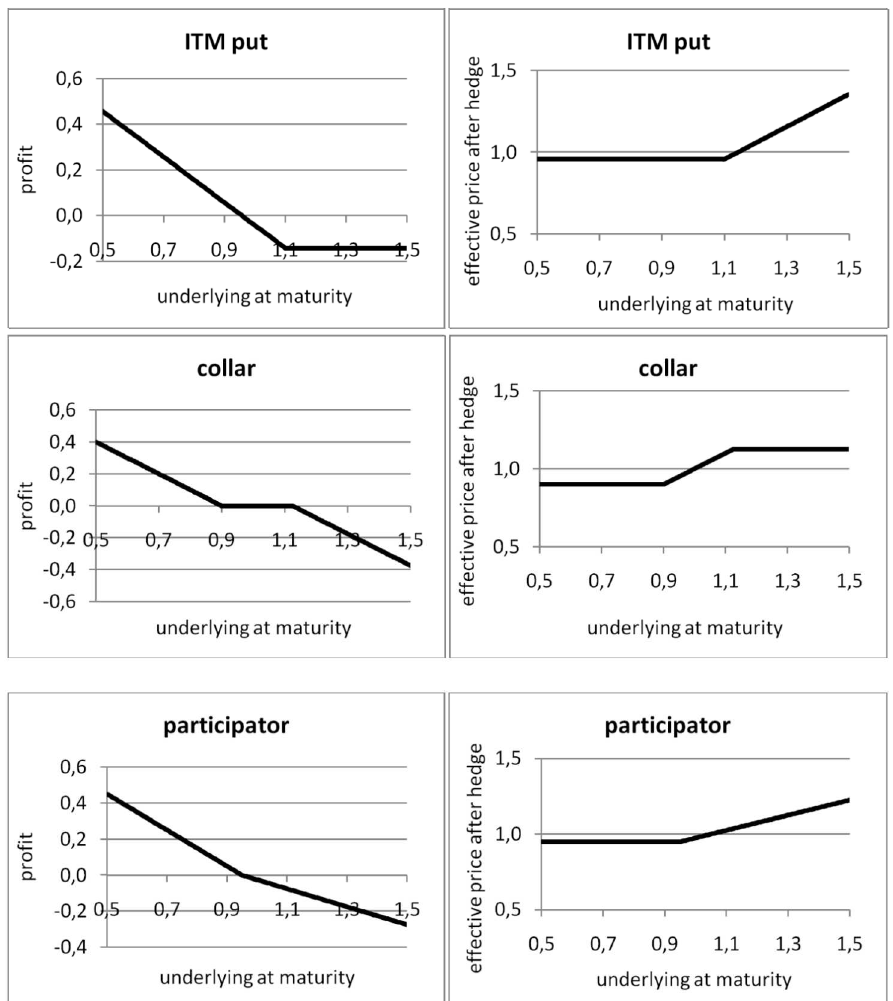
Figure 1. Profit-loss profile (left side) and effective price after hedge (right side) of considered hedging strategies Source: own